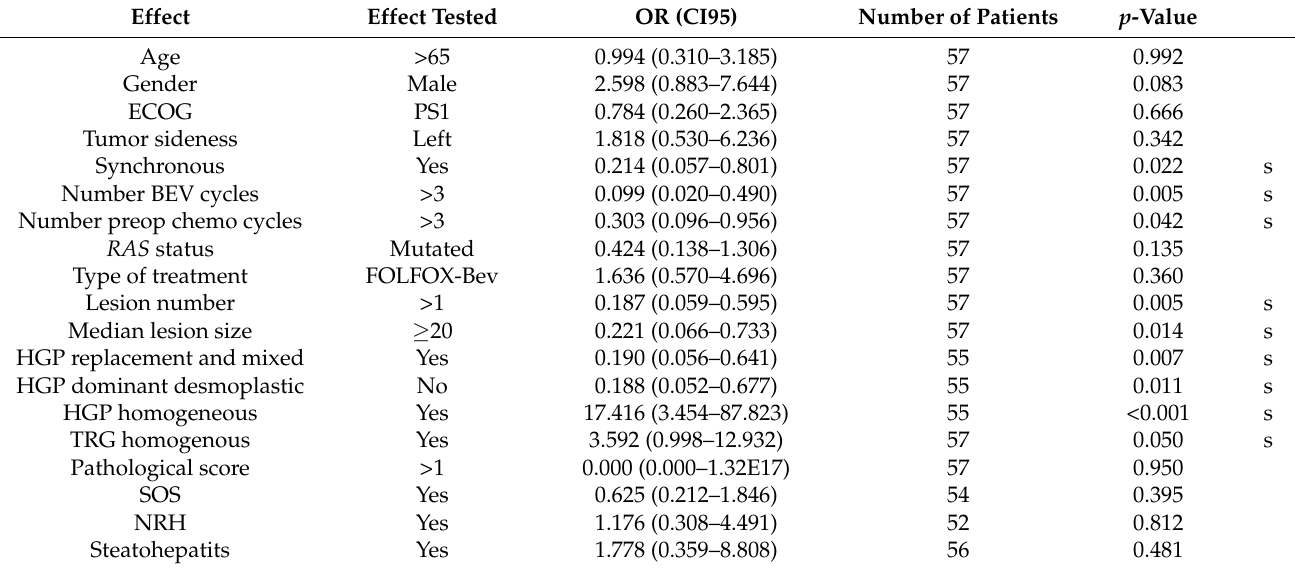
Table 3. Univariate logistic regression for max TRG ≤